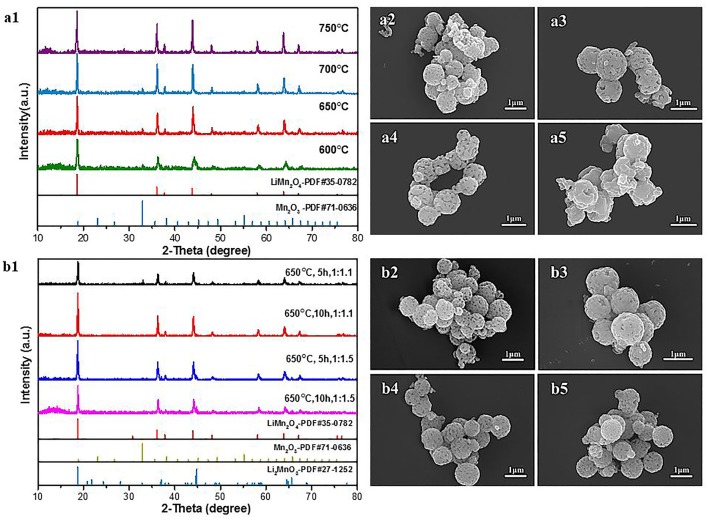
(a1) XRD patterns of LiMn2O4 heated at different temperature. (a2–a5) SEM images of LiMn2O4 heated at different temperature for 5 h. (a2) 600°C (a3) 650°C (a4) 700°C (a5) 750°C. (b1) XRD patterns of LiMn2O4 heated at different Mn2O3: LiOH and calcination times. (b2–b5) SEM images of LiMn2O4 heated at different Mn2O3:LiOH and calcination times. (b2) 1:1.1, 5 h (b3) 1:1.1, 10 h (b4) 1:1.5, 5 h (b5) 1:1.5, 10 h.